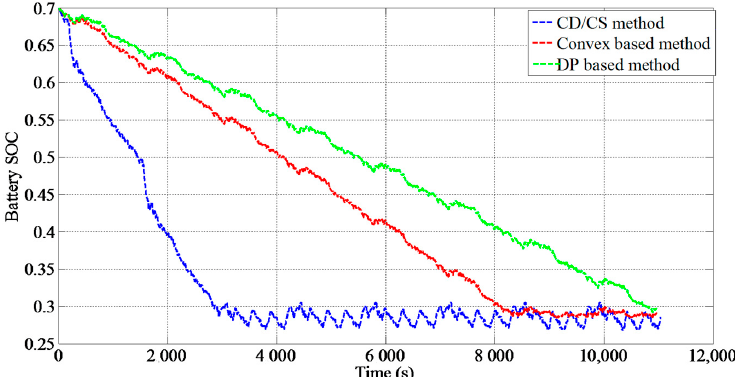
Figure 15. Battery SOC comparisons when the initial SOC is 0.7. Table 5. Results comparison with different initial SOC.